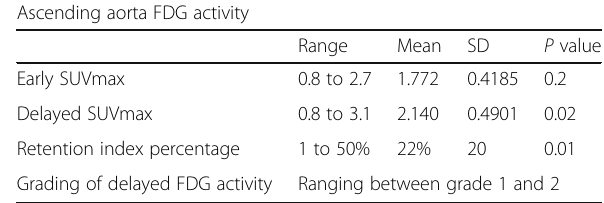
Table 4 Ascending aorta FDG dual point quantitative parameters in the 50 patients of study